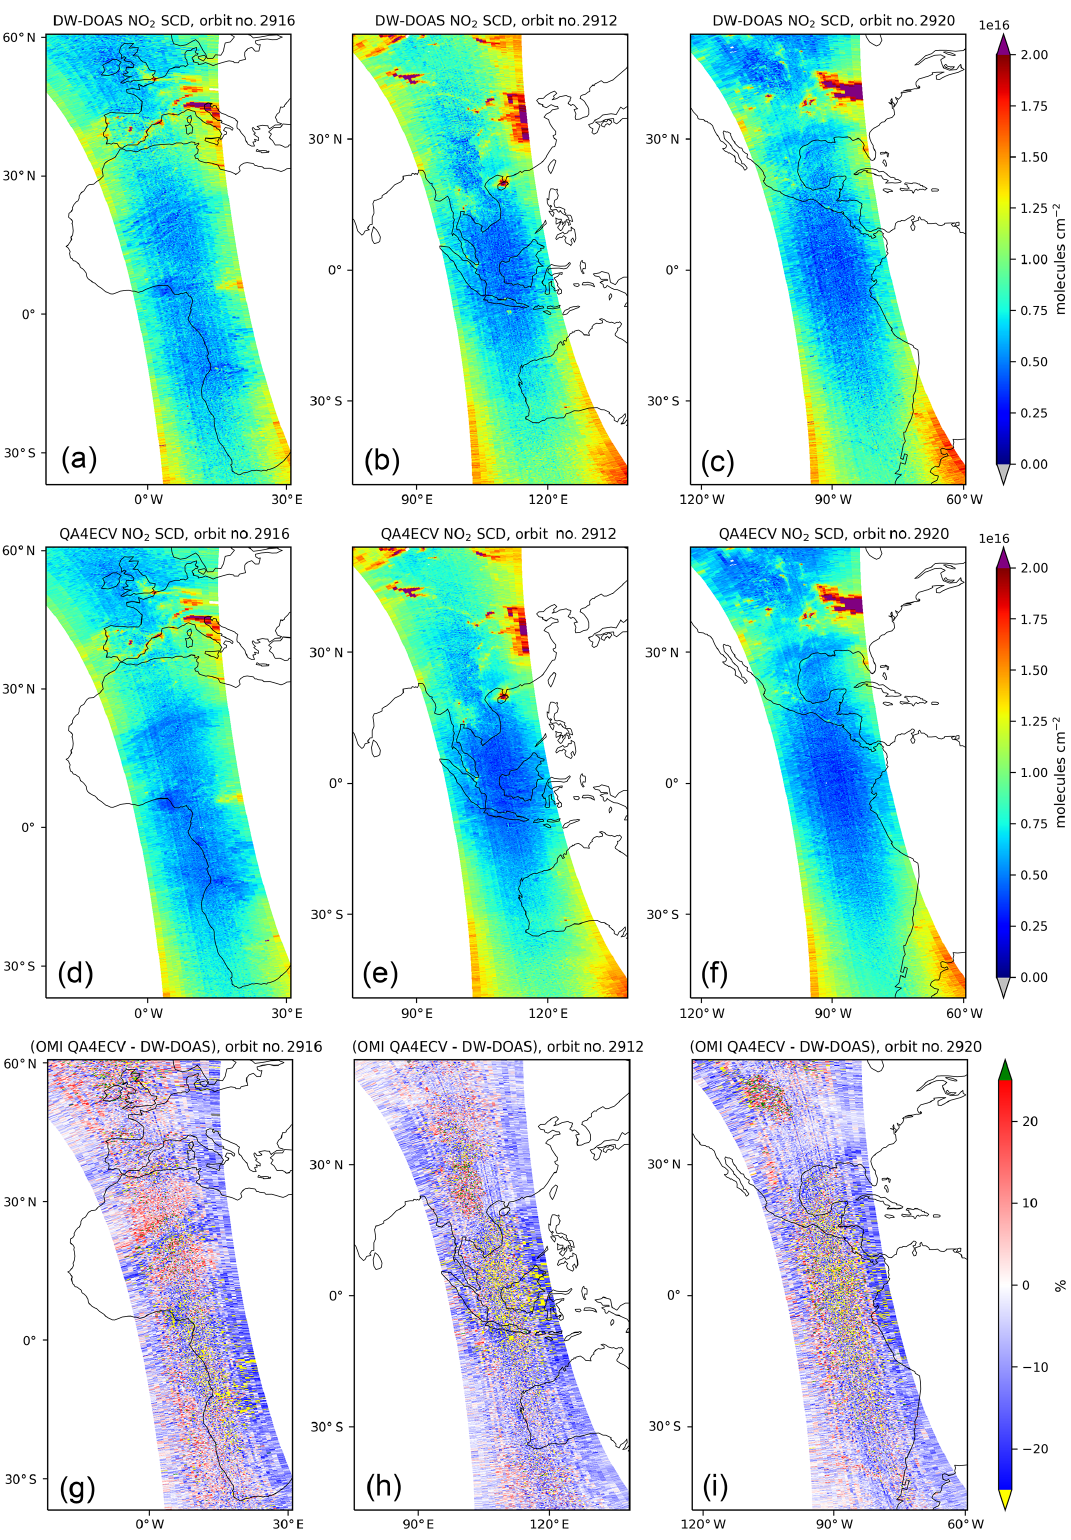
Figure 3. (a, b, c) NO 2 SCDs retrieved by DW-DOAS for selected orbits of 31 January 2005 in all-sky conditions, (d, e, f) corresponding QA4ECV NO 2 SCDs, and (g, h, i) the relative differences between them calculated as (QA4ECV – DW-DOAS) / QA4ECV and expressed in